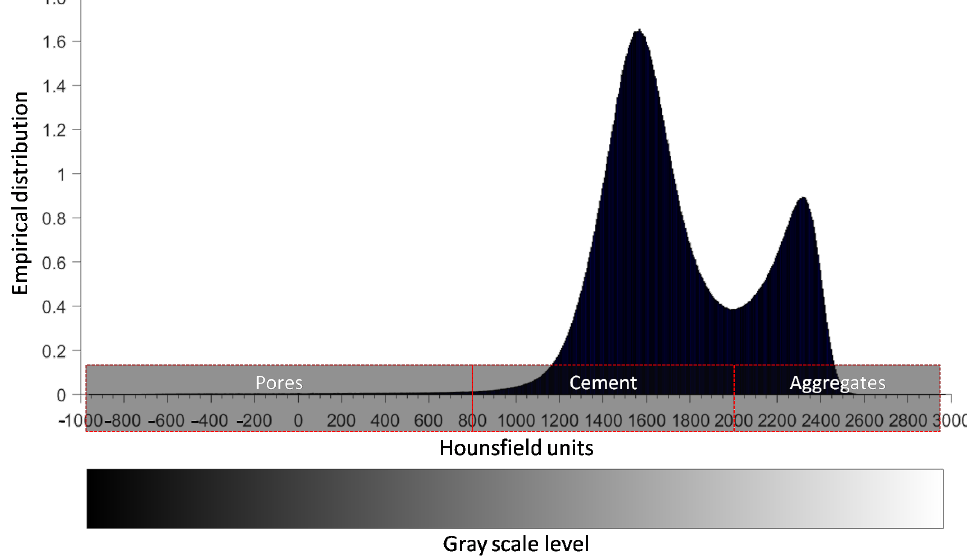
Figure 4. Empirical distribution of Hounsfield unit (HU) values derived from all CT images followed by the range of HU for concrete constituent